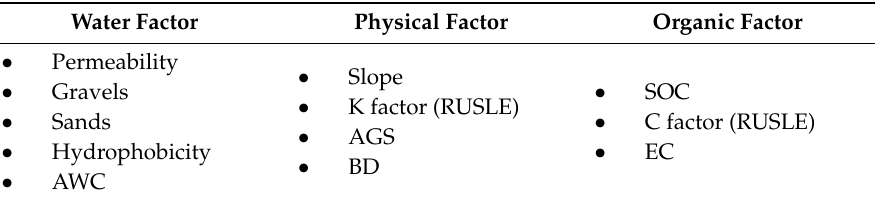
Table 2. Soil quality properties and indicators